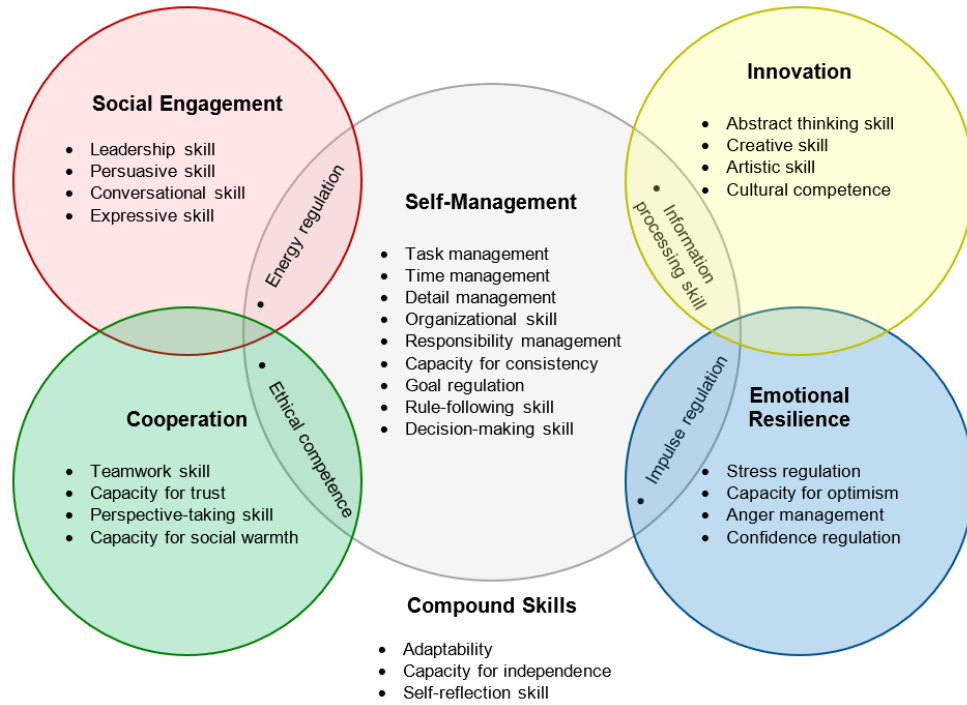
Figure 1. SEB skill domains and facets in the BESSI framework proposed by Soto et al. (2022).